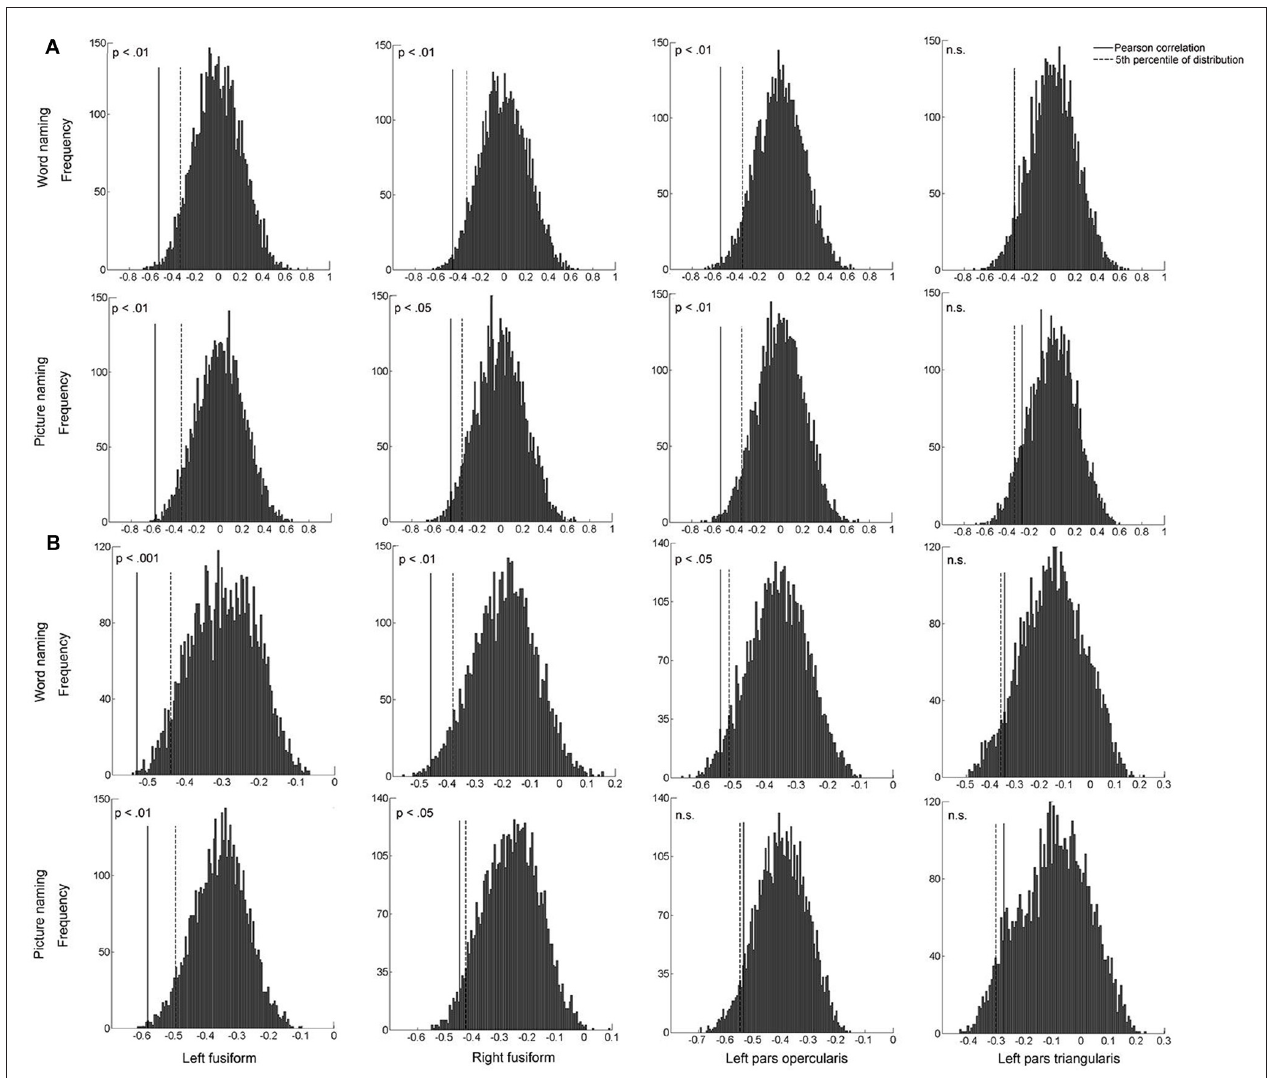
FIGURE 6 | The histogram plots of between-subject permutation test (A) and within-subject permutation test (B) . The solid line indicates the actual correlation between pattern similarity of artificial language words and behavioral performance, and the dashed line indicates the 5th percentile (0.05) of the distribution. X -axis represents the correlation